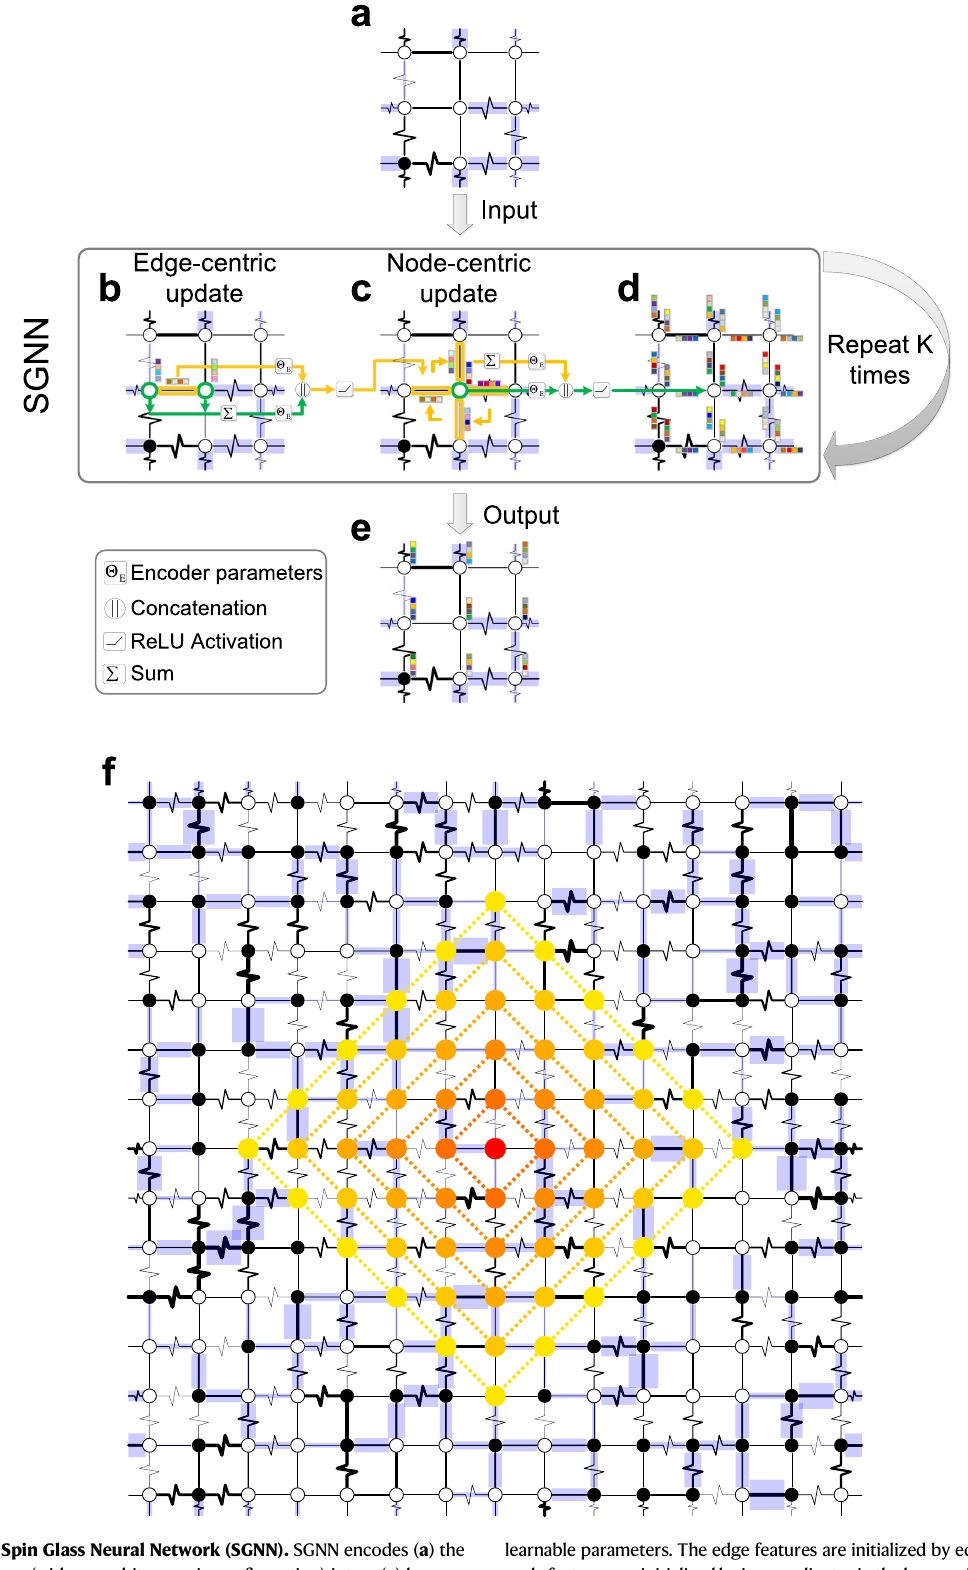
learnable parameters. The edge features are initialized by edge weights, and the nodefeaturesareinitializedbyitscoordinatesinthehypercubiccoordinatesystem. d , Each node oredge updates its embedding vector in one layer. Repeating several layers,weobtainanembeddingvectorforeachnode( e )thatre fl ectsitsinformative features. f ,Eachlayerofupdatesincreasesthelong-rangecouplingswithonemore hop ’ s neighbors (dashed lines) for a given spin. For example, for the central spin (colored in dark red), its fi nal embedding vector after K =5 layerscaptures both its position and its long-range couplings with neighbors within K =5